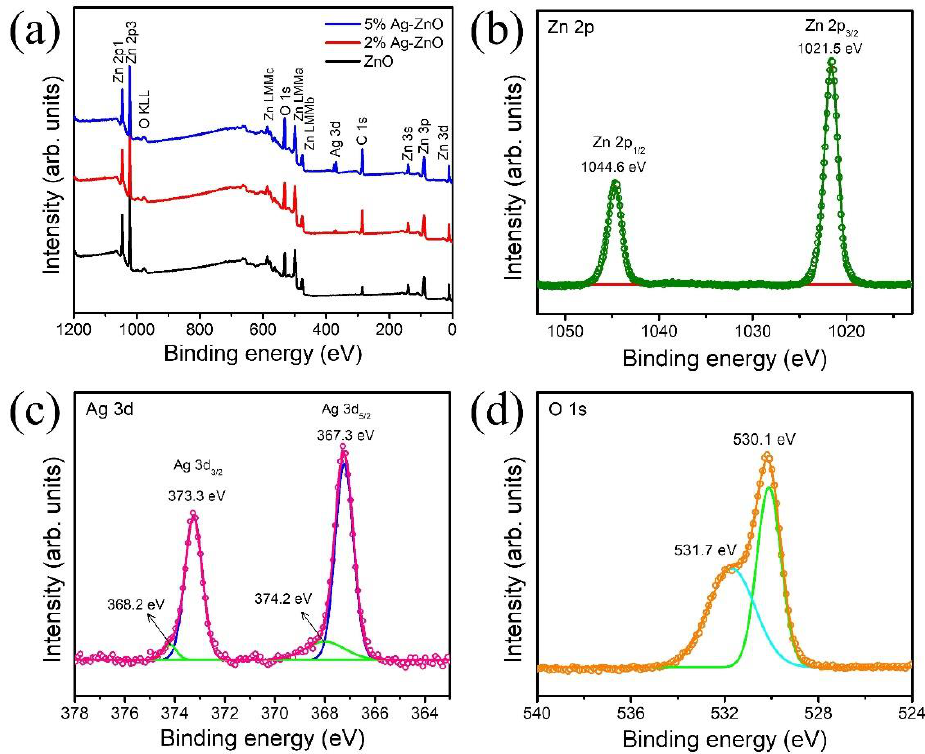
Figure 3. ( a ) Full scan survey spectra of pure ZnO and Ag-ZnO, and high-resolution XPS spectra of the Zn 2p ( b ), Ag 3d ( c ), and O1s ( d ) of the 5% Ag-ZnO.